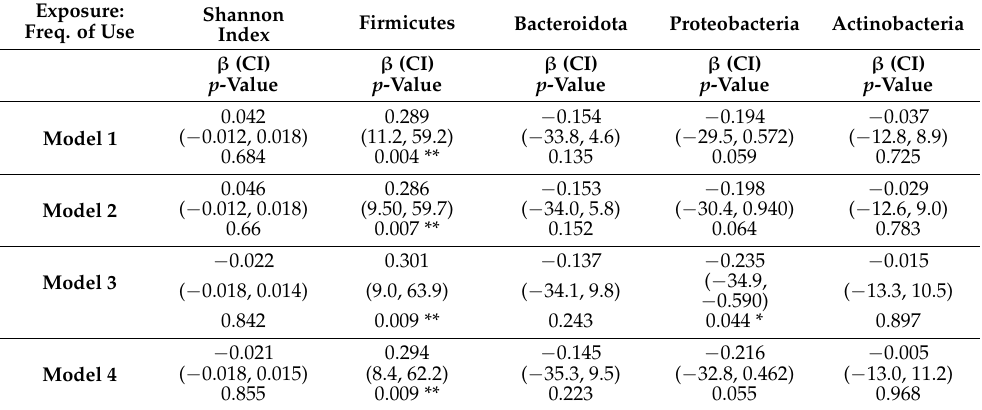
Model 4: Model 3 + Total number of supplements and medications used. Table 4. Association between total number of herbs used with high frequency and outcome variables.